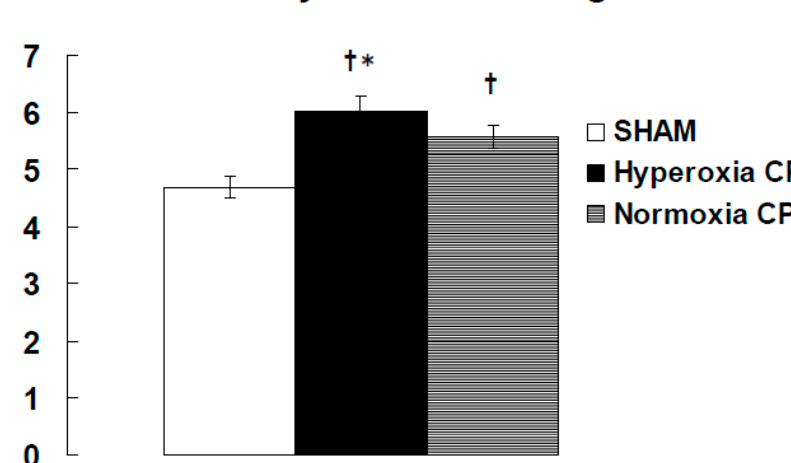
Figure 4. The wet-to-dry weight (W / D) ratio of the lung at the end of experiment [25]. † p < 0.05 versus the SHAM group, * p < 0.05 versus the Normoxia CPB group.